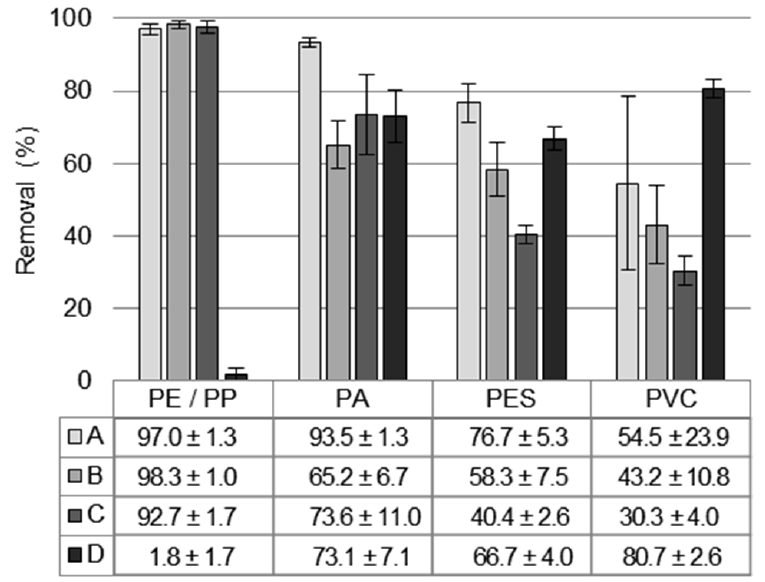
Figure 4. Removal efficiency for 100 mg microplastics from 1 L demineralized water using 100 µL organosilane (A = PE-X; B = n-Butyltrichlorosilane; C = Isooctyltrichlorosilane; D = (3-Chloropro-